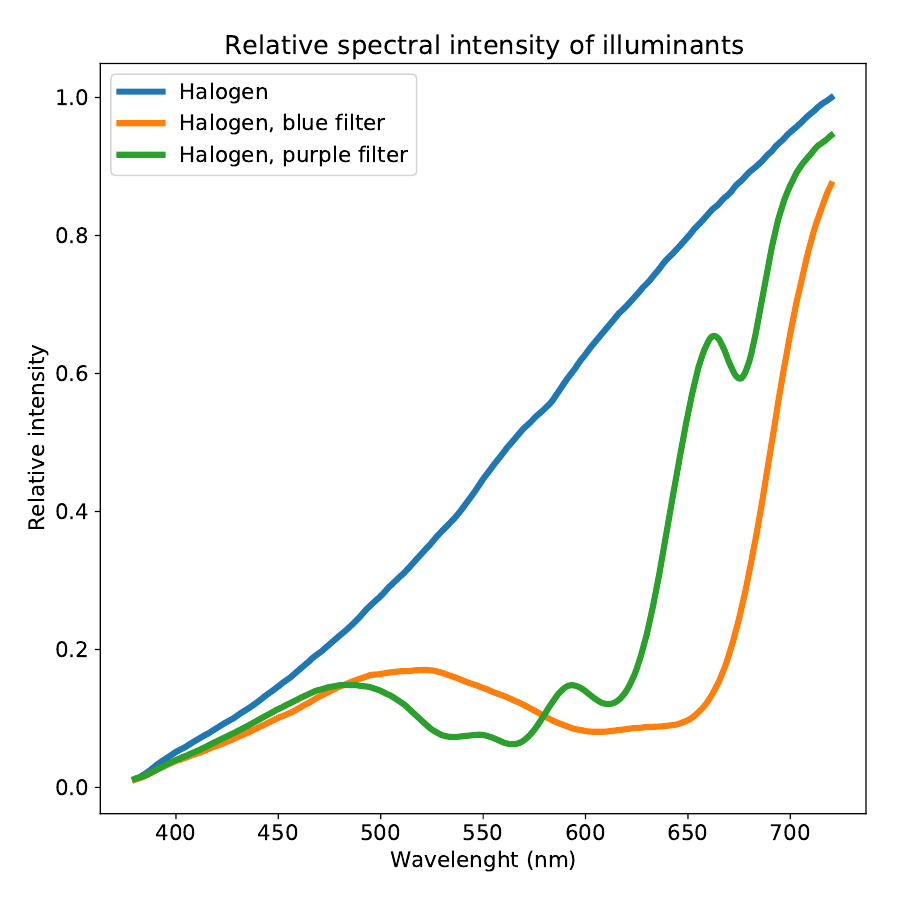
Figure 3. Spectra of the illuminants used to generate diffraction images as presented in Figure 2. The equipment is unable to estimate sensor sensitivity below wavelengths of approximately 380 nm, due to all illuminants having very low